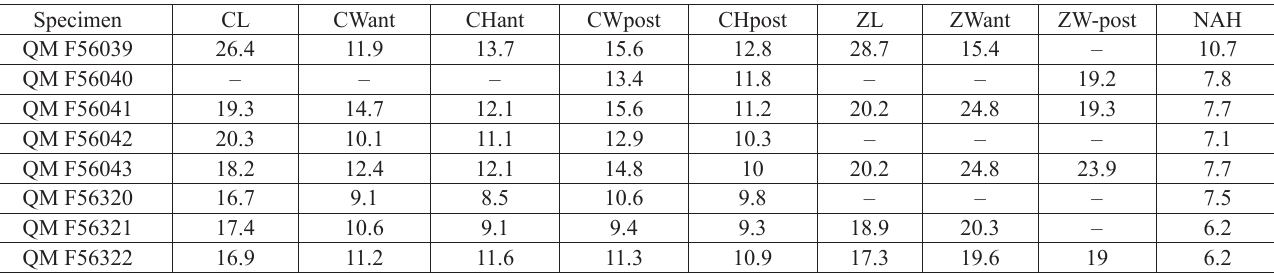
Table 1. Selected measurements (in mm) of mekosuchine vertebrae collected from Riversleigh. Abbreviations: CHant, anterior dorsoventral height of centrum; CHpost, posterior dorsoventral height of centrum; CL, anteroposterior length of centrum; CWant, anterior mediolateral width of cen- trum; CWpost, posterior mediolateral width of centrum; NAH, dorsoventral height of nerual arch; ZL, anteroposterior length of zygapophyses; ZWant, mediolateral width of anterior zygapophyses; ZWpost, mediolateral width of posterior zygapophyses. Specimen CL CWant CHant CWpost CHpost ZL ZWant ZW-post NAH QM F56039 QM